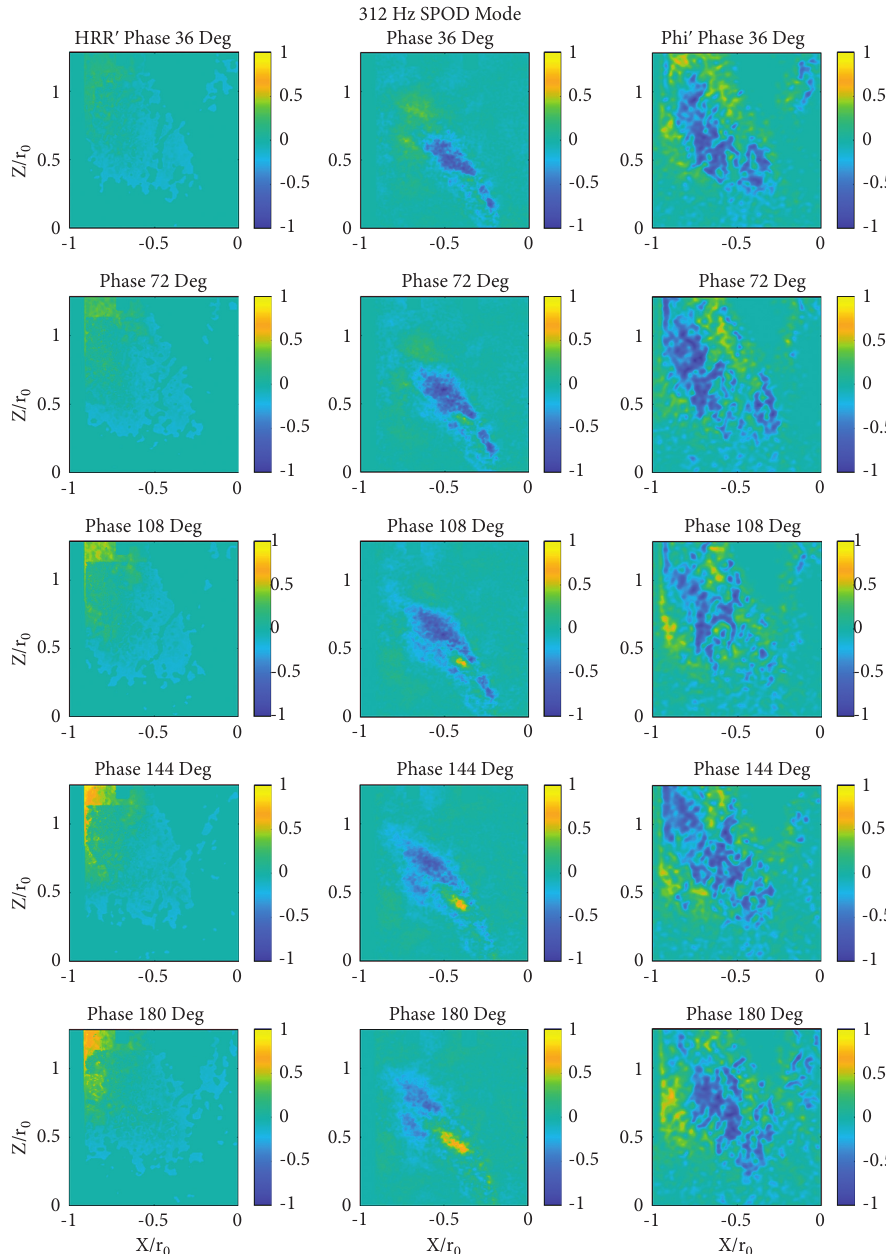
Figure 17: Comparison of phased averaged heat release fluctuations (HRR), SPOD mode at 312Hz, and phased averaged equivalence ratio fluctuations (Phi) for the first five